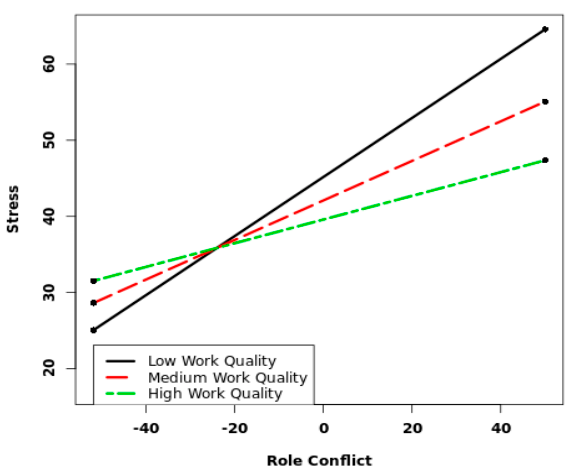
Figure 2. The moderation of staff-assessed care quality on the association between role conflict and stress among dental nurses.